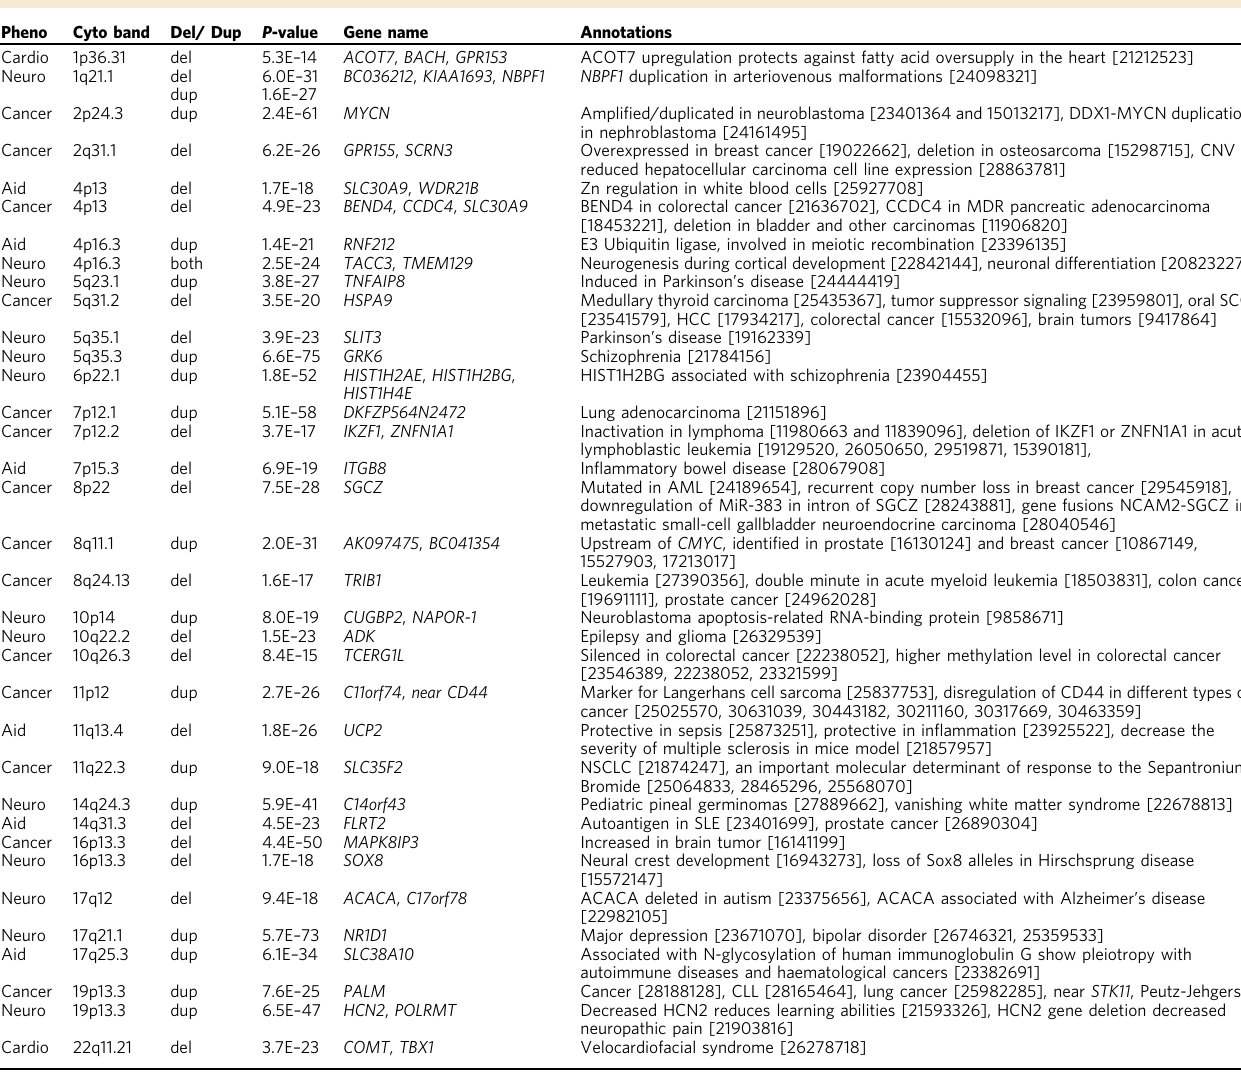
Table 1 Select loci enriched with CNVs in four major disease categories. Pheno Cyto band Del/ Dup P -value